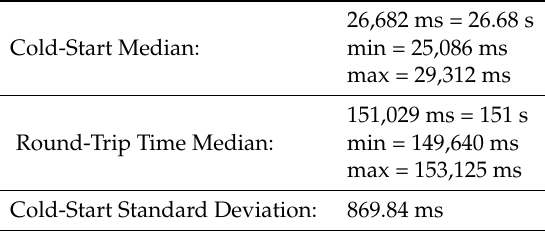
Table 6. Descriptive Statistics Scale